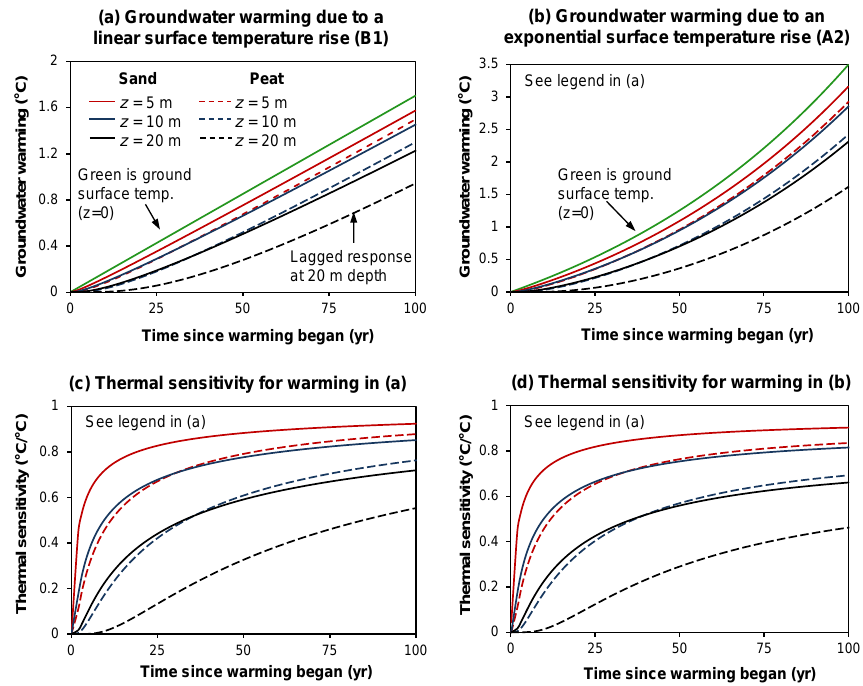
Figure 8. Groundwater temperature warming due to a linear trend (a) and an exponential trend (b) in surface temperature vs. the time since the surface warming began. (c) and (d) groundwater thermal sensitivity vs. time for each of the six scenarios presented in (a) and (b) , respectively. The results shown in (a) were obtained with Eq. (13) with β = 5.41 × 10 − 10 ◦ Cs − 1 based on the IPCC B1 projections and setting T 0 = 0 ◦ C. The results shown in (b) were obtained with Eq. (15) where T 1 , b , and c are − 1.59 ◦ C, 1.59 ◦ C, and 3.68 × 10 − 10 s − 1 , respectively (to match the IPCC A2 projections). The subsurface thermal properties were for 50% saturated soil (Table 2), and the recharge rate was 20cmyr − 1 . The aquifer thermal sensitivities shown in (c) and (d) were calculated with Eqs. (18) and (19),